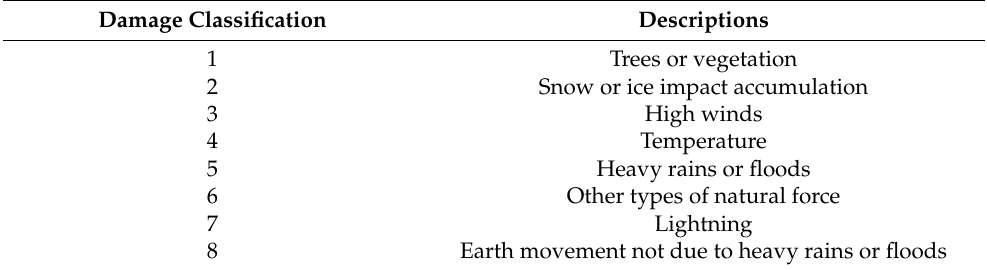
Table 1. Natural force damage type for